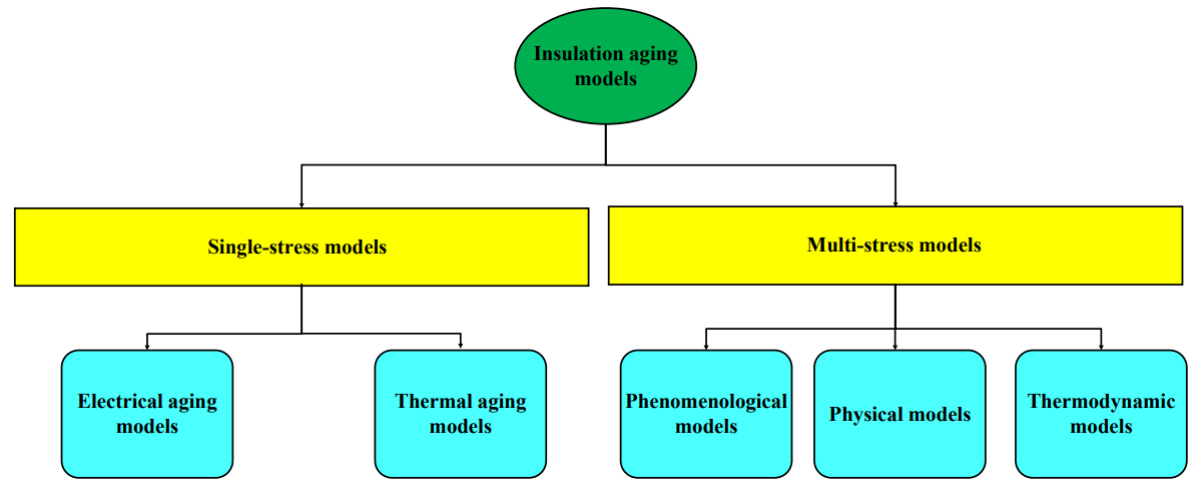
Figure 3. Classification of insulation-aging models.